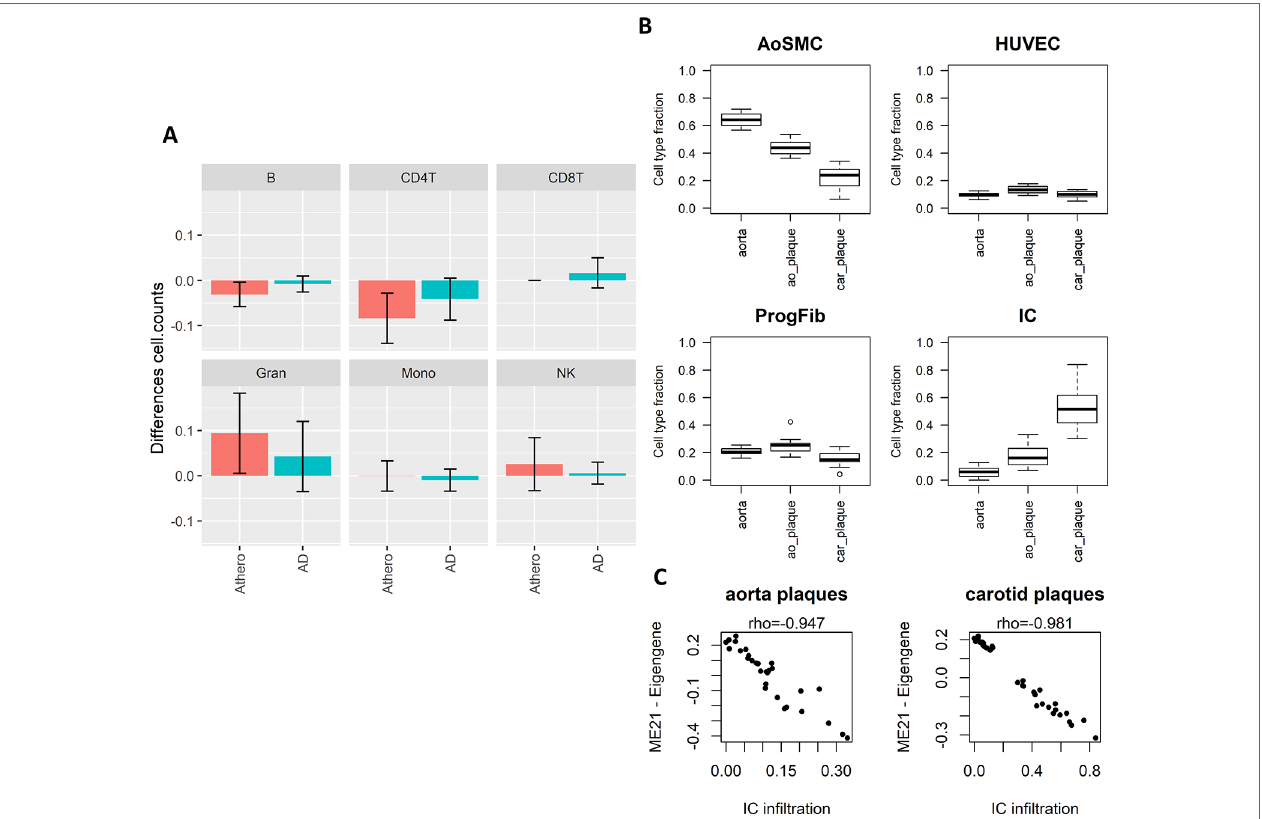
FIgURe 4 | Weighted Correlation Network Analysis (WGCNA) consensus module is influenced by underlying immune cell type composition and immune cell infiltration. (A) Blood immune cell type (B-cells, NK-cells, CD4+ T-cells, CD8+ T-cells, granulocytes, and monocytes) composition shift in atherosclerosis (blue) and Alzheimer's disease (AD) (green) patients compared to controls estimated by the method of Houseman. Error bars represent 95% confidence intervals. (B) Estimated cell type composition in healthy aorta, aorta atherosclerotic plaque (ao_plaque), and carotid plaque (car_plaque). Relative cell type composition was estimated using reference methylomes of aortic smooth muscle cells (AoSMC), endothelial cells (HUVEC), fibroblasts (ProgFib), and immune cells (IC) (see Methods for more details). (C) Correlation between estimated IC infiltration and the eigengenes of the WGCNA consensus module (ME21) in aorta and carotid plaques. A negative correlation was found between estimated IC infiltration and ME21 eigengenes, which corresponds with the negative association found between module ME21 eigengenes and methylation in AD and atherosclerosis (i.e., AD and atherosclerosis patients have lower ME21 eigengenes compared to controls).